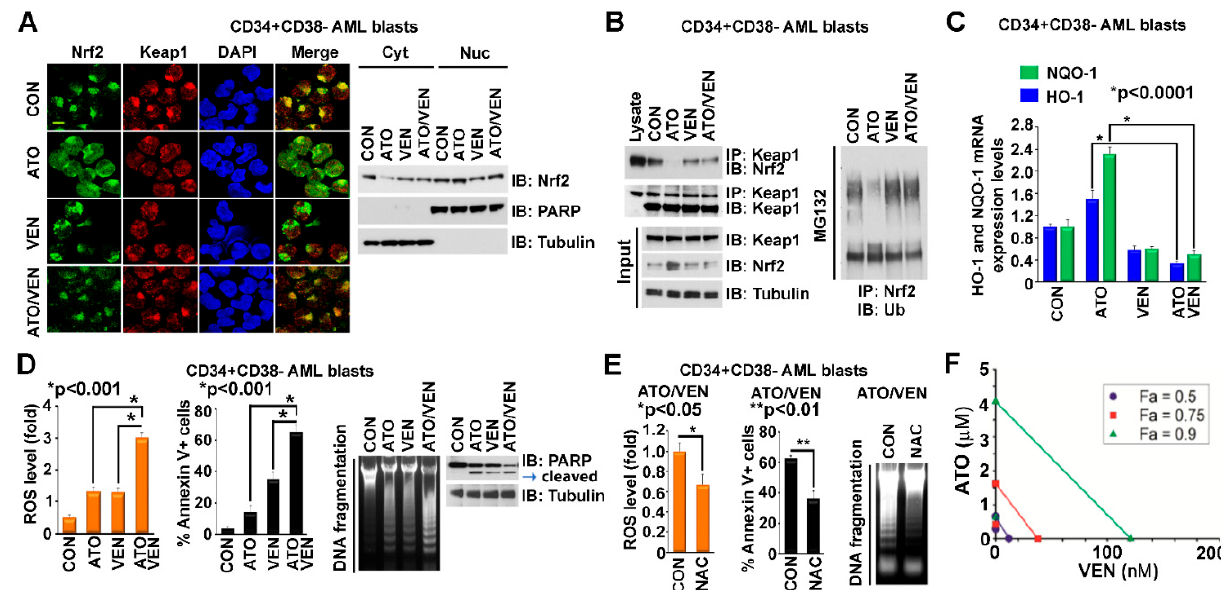
Figure 3. Addition of VEN to ATO inhibits Nrf2 nuclear translocation, augments ROS and increases apoptosis in LSC-enriched AML progenitor cells. ( A ) Effects of VEN on ATO-induced Nrf2 translocation. LSC-enriched progenitor cells were treated with 500 nM ATO, 10 nM VEN, or both. Left, the cells were stained with anti-Nrf2 and anti-Keap1 antibodies. Scale bar, 10µm. Right, the cells were fractionated into cytoplasmic and nuclear parts and immunoblotted with indicated antibodies. ( B ) Effects of VEN on ATO-regulated Nrf2/Keap1 binding and Nrf2 ubiquitylation. LSC-enriched progenitor cells were treated as described in ( A ). Left, cell lysate was immunoprecipitated with anti-Keap1 and immunoblotted with anti-Nrf2 antibodies. Input controls are shown. Right, cell lysate was immunoprecipitated with anti-Nrf2 and immunoblotted with anti-Ub antibodies. ( C , D ) Effects of VEN on ATO-regulated levels of NQO-1/HO-1 expression, mitochondrial ROS and apop- tosis in LSC-enriched progenitor cells treated as described in ( A ). ( C ) mRNA levels of NQO-1 and HO-1 (normalized to GAPDH). ( D ) Left, mitochondrial ROS levels. Middle and right, apoptosis levels by Annexin V flow cytometry, genomic DNA fragmentation, and PARP cleavage. ( E ) Effects of NAC pre-treatment on ATO+VEN-regulated levels of ROS and apoptosis in LSC-enriched pro- genitor cells. Cells were treated with ATO (500 nM) and VEN (10 nM) in the presence of DMSO control or NAC (2.5 mM). Left, mitochondrial ROS levels. Middle and right, apoptosis levels by Annexin V flow cytometry and DNA fragmentation. ( F ) Synergistic effects of ATO and VEN on cell viability. LSC-enriched progenitor cells were cultured with ATO, VEN or ATO+VEN, at increasing concentrations, for 72 h, followed by MTS assay. The synergistic interaction between VEN and ATO was analyzed using CalcuSyn program and isobolographic representation of the combination is shown. The individual doses of VEN and ATO to achieve 90% (green line), 75% (red line), and 50% (dark blue line) growth inhibition were plotted on the x and y axes. Combination index values are represented by points above (indicating antagonism) or below the lines (indicating drug synergy). The isobologram demonstrates drug synergy for all dose combinations